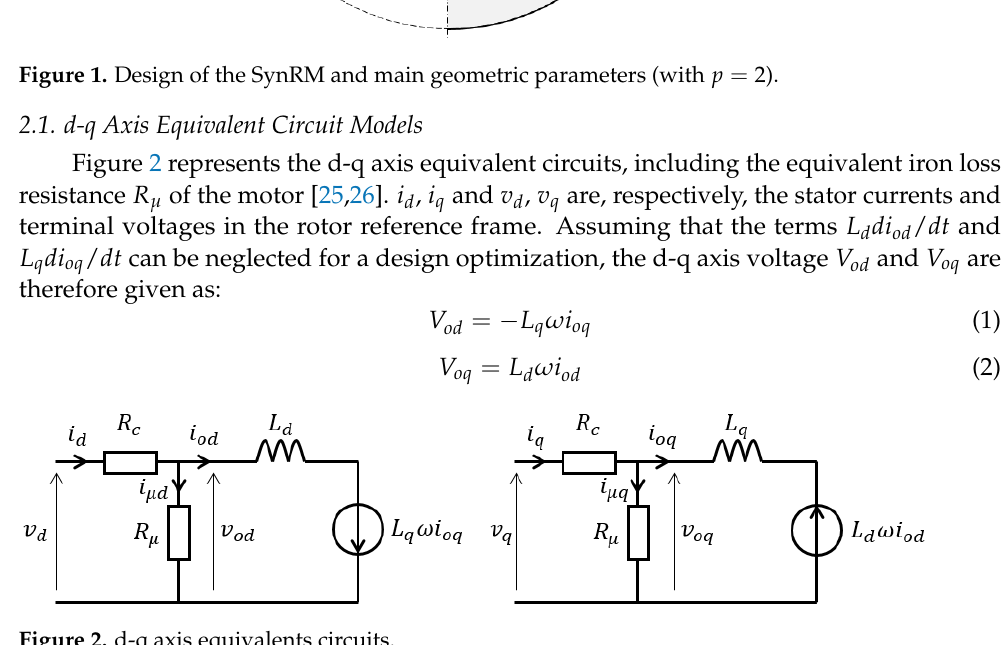
Figure 1. Design of the SynRM and main geometric parameters (with 𝑝 (cid:3404) 2 ).